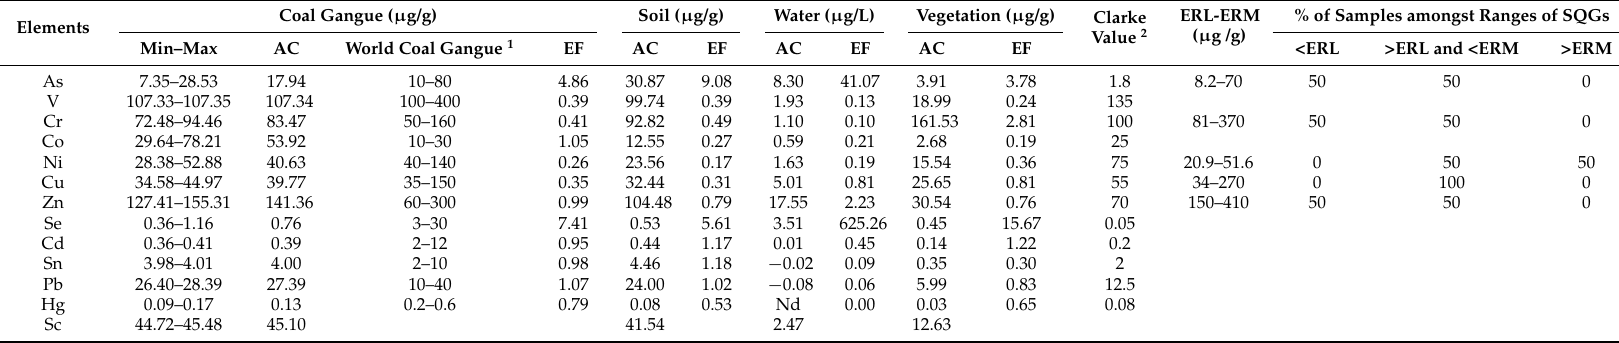
Table 3. Concentrations of the 12 elements in coal gangue, soil, water and vegetation in the Wulantuga open-cast coal mine area. SQGs, sediment quality guidelines.